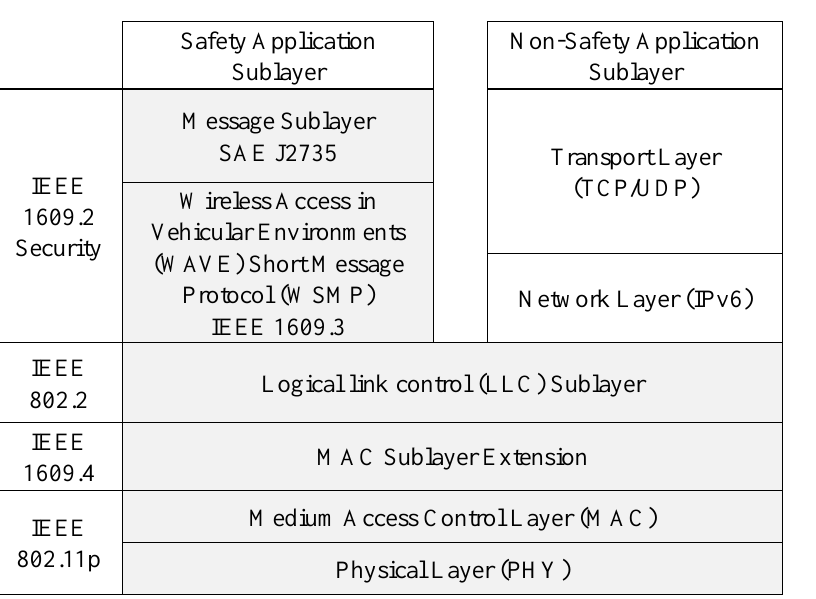
Figure 1. WAVE/DSRC communication’s layered architecture